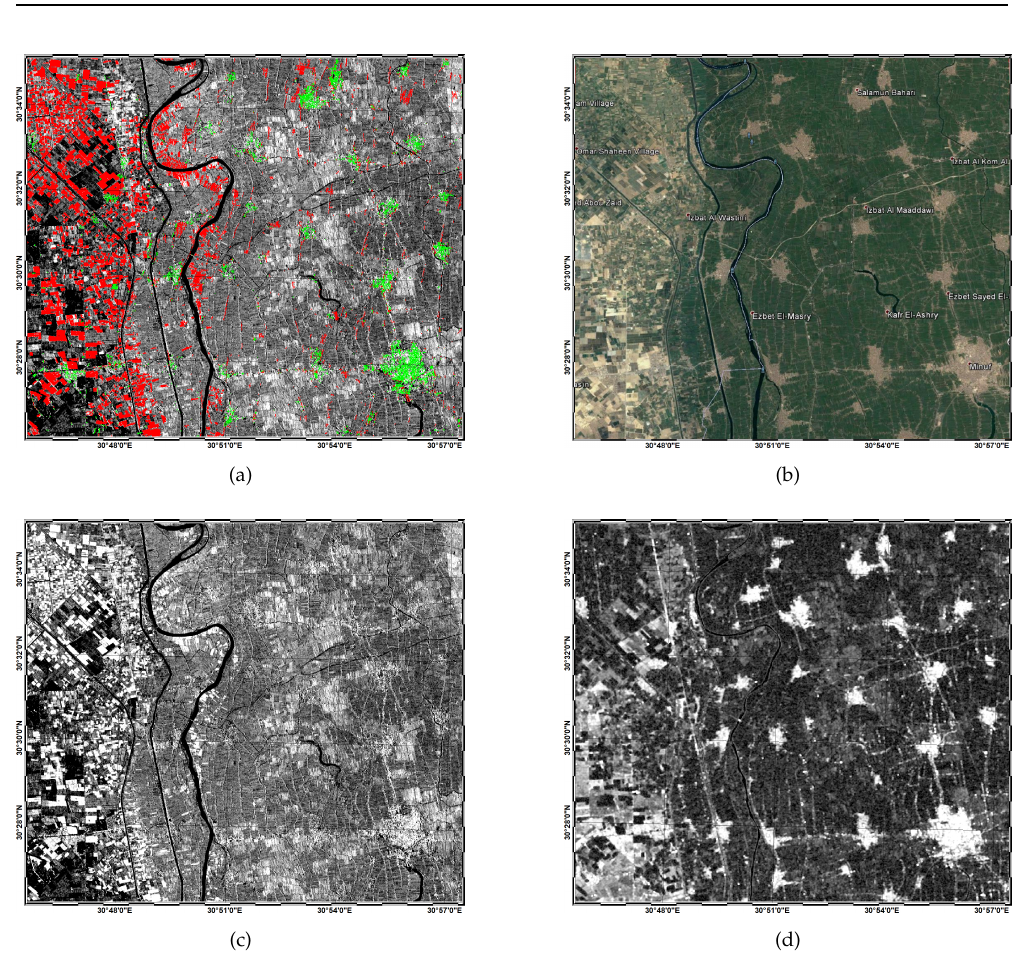
Figure 5. Illustration of the usefulness of the coherence information for reducing the vegetation false alarms which are strongly noticeable in the intensity TAI (temporal average intensity) image, Egypt ( c ). ( a ) red—areas removed by the coherence (temporal average coherence (TAC)) filter, green—areas retained by the TAC filter in the S1BM product; ( b ) optical image of the scene (source: Google Earth); ( c ) intensity image; ( d ) coherence